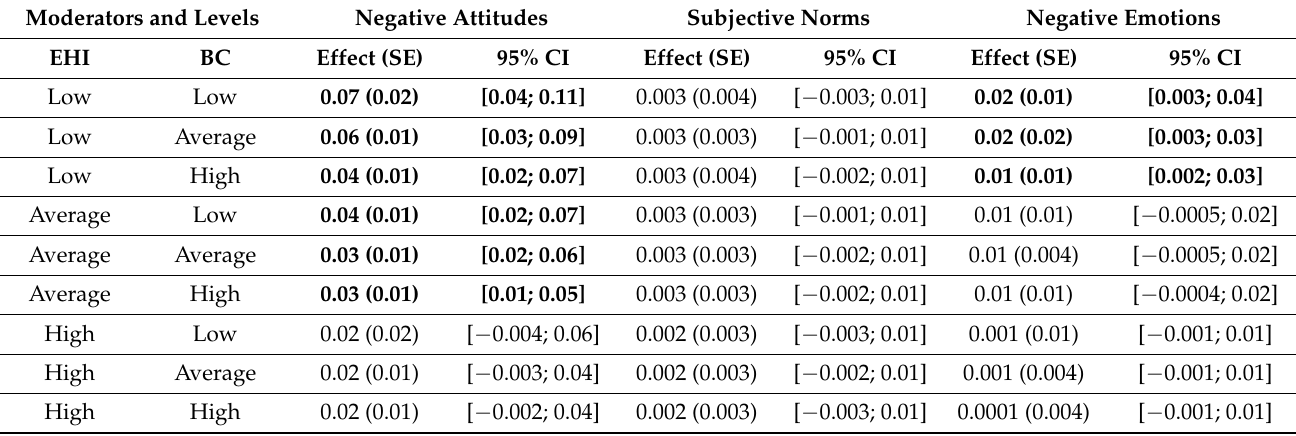
Table 3. Conditional indirect effects for the two moderators.